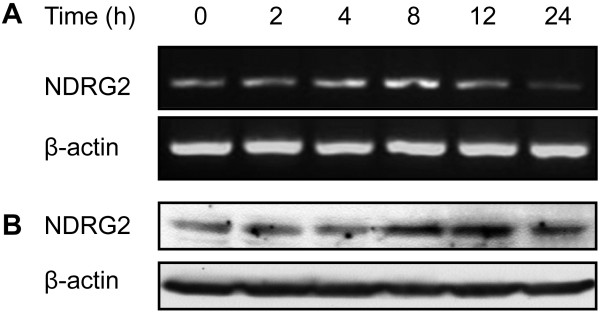
NDRG2 expression in Hela cells was enhanced by cisplatin. Hela cells were exposed to cisplatin (5 μg/ml) for the indicated time. NDRG2 expression was evaluated by RT-PCR (A) and Western blot (B) analysis. β-actin served as internal control. Shown are representative of 3 independent experiments.